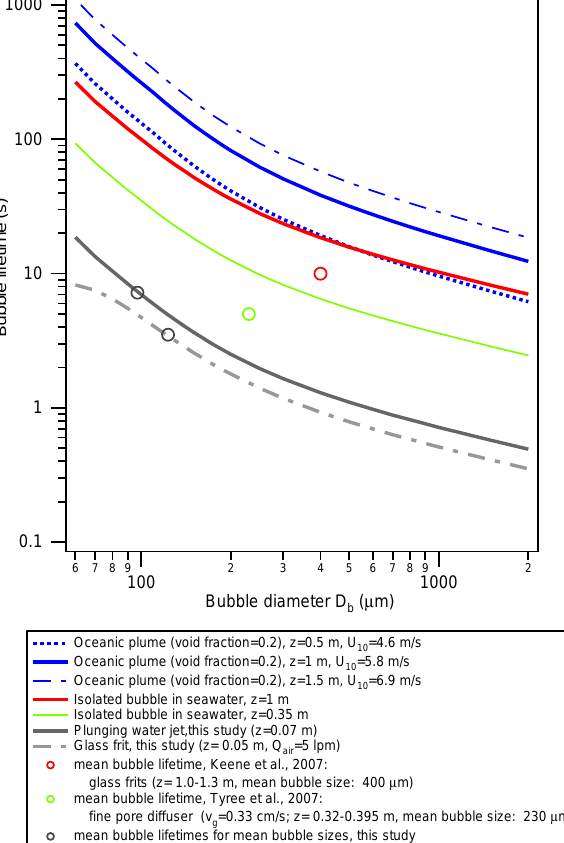
Fig. 11. Comparison of estimated lifetimes of bubbles generated by the plunging-water jet system and the glass sintered filter in this study with lifetimes reported by Keene et al. (2007) and Tyree et al. (2007), and oceanic plume lifetimes at 4.6ms − 1 , 5.8ms − 1 and 6.9 ms − 1 wind speeds at a breaking wave event ( z =bubble path, U 10 =wind speed at 10m above the surface). Lifetimes of isolated bubbles at 1m and 0.35m depths are included for